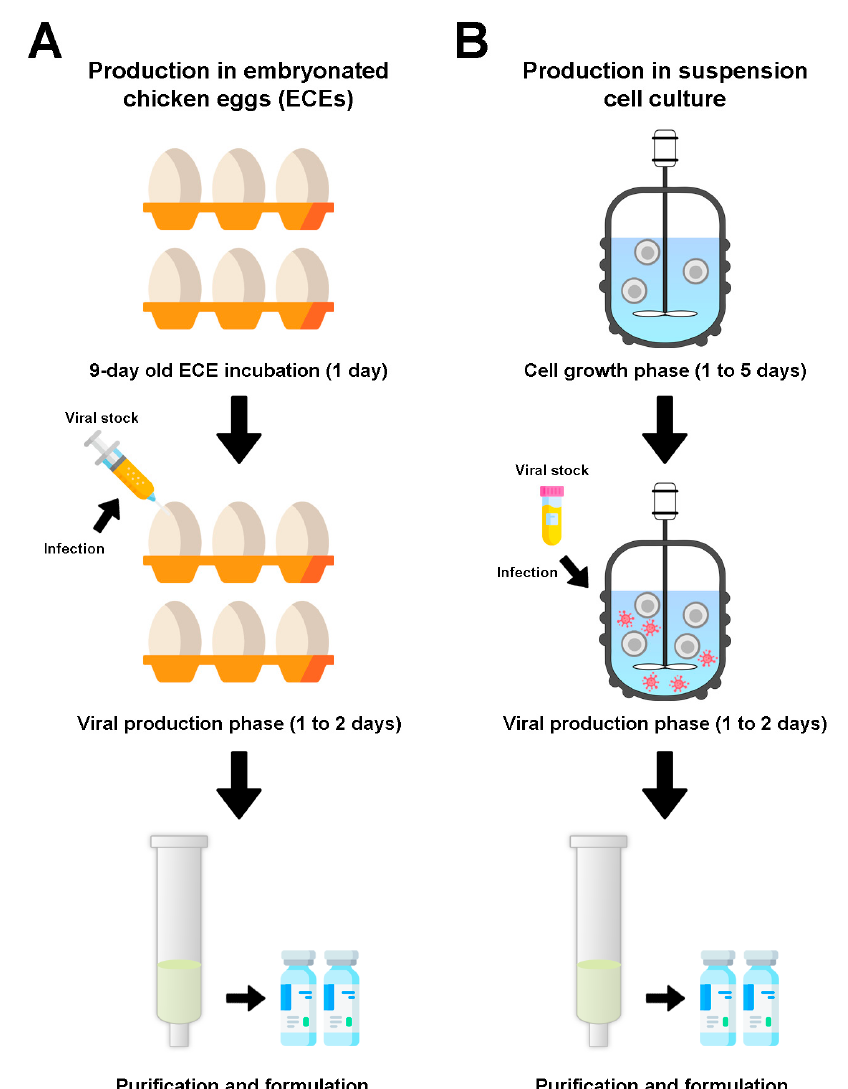
Figure 2. Overview of production processes for viral-vectored vaccines in ( A ) embryonated chicken eggs (ECEs) and ( B ) suspension cell cultures in stirred-tank bioreactors.